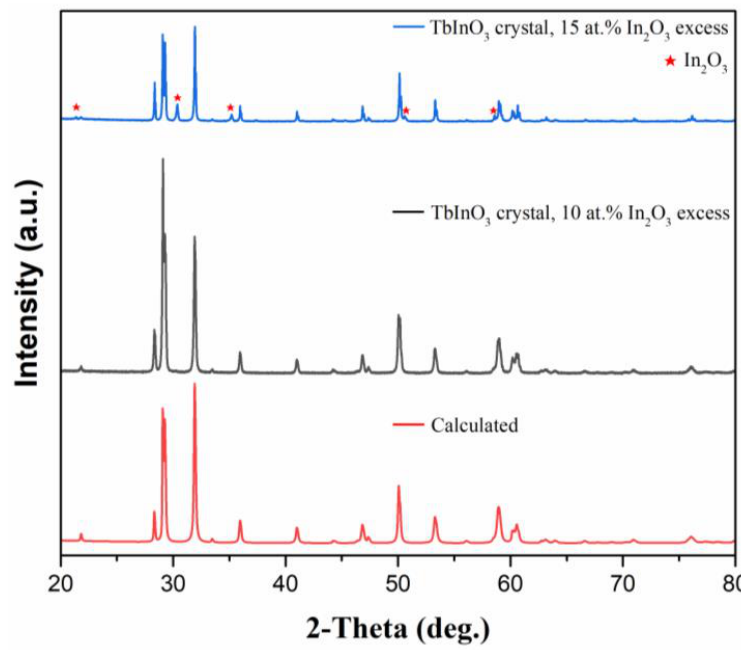
Figure 1. XRD of TbInO 3 crystals.